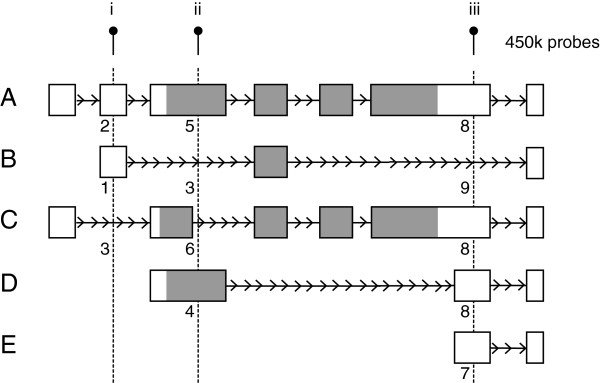
Illustration of gene feature annotation. Based on the overlap of three gene components (first exon vs exon vs intron) with three gene regions (5’UTR vs body vs 3’UTR) probes were annotated into the following nine gene feature groups: 1) 5’UTR first exons, 2) 5’UTR exons, 3) 5’UTR introns, 4) body first exons, 5) body exons, 6) body introns, 7) 3’UTR first exons, 8) 3’UTR exons and 9) 3’UTR introns (corresponding to numbers below transcripts). A given probe could be annotated with more than one gene feature, as illustrated by the multiple transcripts (A to E) of a fictional gene. Probe i would be annotated as 5’UTR exon, 5’UTR first exon and 5’UTR intron; probe ii would be annotated as body exon, 5’UTR intron, body intron, body first exon; and probe iii would be annotated as 3’UTR exon, 3’UTR intron, 3’UTR exon, 3’UTR exon and 3’UTR first exon. White boxes represent untranslated exons, grey boxes represent translated exons. 5’UTR, 5’ untranslated region; 3’UTR, 3’ untranslated region.